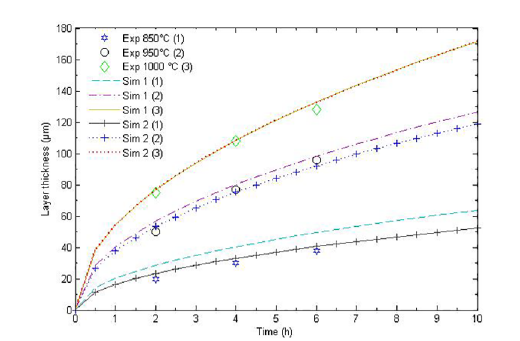
Figure 5. Comparison of the simulated thickness (sim1), (sim2) measured for different